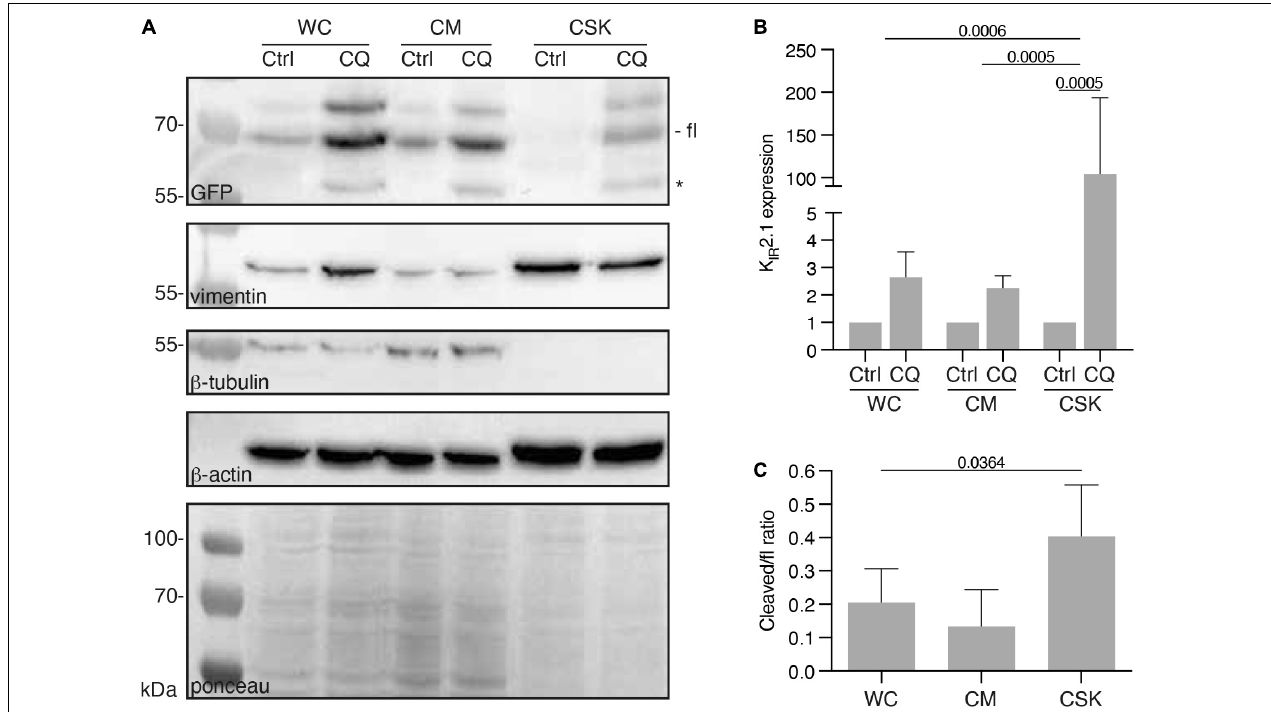
FIGURE 5 | Presence of K IR 2.1-GFP in the cytoskeleton containing cell fraction, induced by Chloroquine treatment. (A) Western blot analysis of whole cell lysates (WC), cytosol and membrane fractions (CM) and cytoskeleton fractions (CSK) of non-treated (NT) and 10 µ M Chloroquine (CQ) (24 h) treated HEK-KWGF cells. All three cytoskeleton components were included as well as a ponceau staining, which was used as loading control. Cleaved K IR 2.1-GFP, indicated with an asterisk, is only present after CQ treatment. Fl, full-length K IR 2.1-GFP. (B) Quantified results of the CQ induced induction of K IR 2.1-GFP expression ( n = 6). One-way ANOVA was used to calculate significance. (C) Quantified results of cleaved/fl K IR 2.1-GFP ratios in all cell fractions ( n = 6). One-way ANOVA was used to calculate